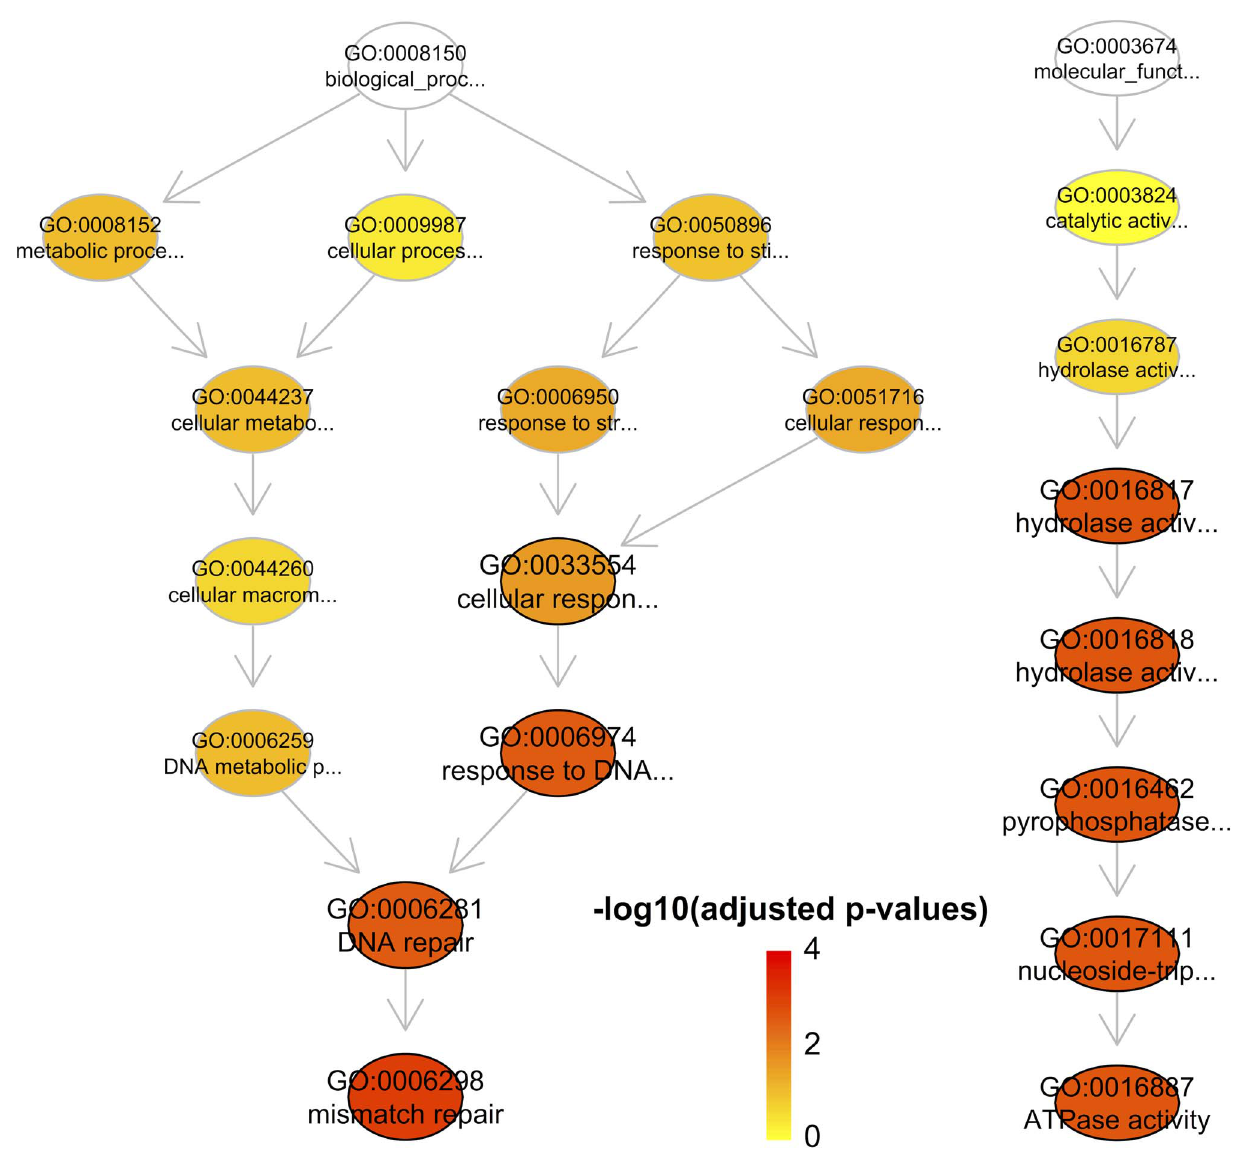
Figure 3. Enrichment analysis of promiscuous Pfam domains using GOBP terms (left) and GOMF terms (right). Only the most significant terms/nodes (adjusted p-values , 0.05; outlined in black) are visualised along with their ancestral terms. Nodes are coloured according to adjusted p-values.